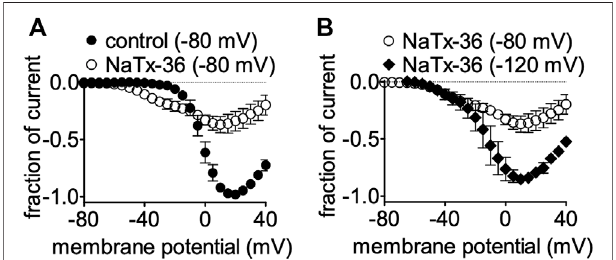
FIGURE 5 | Effects of NaTx36 on OtNav1.8 steady-state fast and slow inactivation. (A,B) Representative steady-state fast inactivation and slow inactivation curves before and after 100 nM NaTx36 application to ND7/23 cells transfected with recombinant OtNav1.8. Cells were pretreated with 500 nM TTX to block TTX-sensitive sodium channels. All Na + currents were normalized to the maximum amplitude of control peak current. (A) Using a double-pulse protocol, Na + currents were induced by a 20-ms depolarizing potential of +30 mV following a 500-ms prepulse at voltages ranging from − 120 to +10 mV. Currents were plotted as a fraction of the maximum peak current. NaTx36 shifted the voltage dependence of steady-state